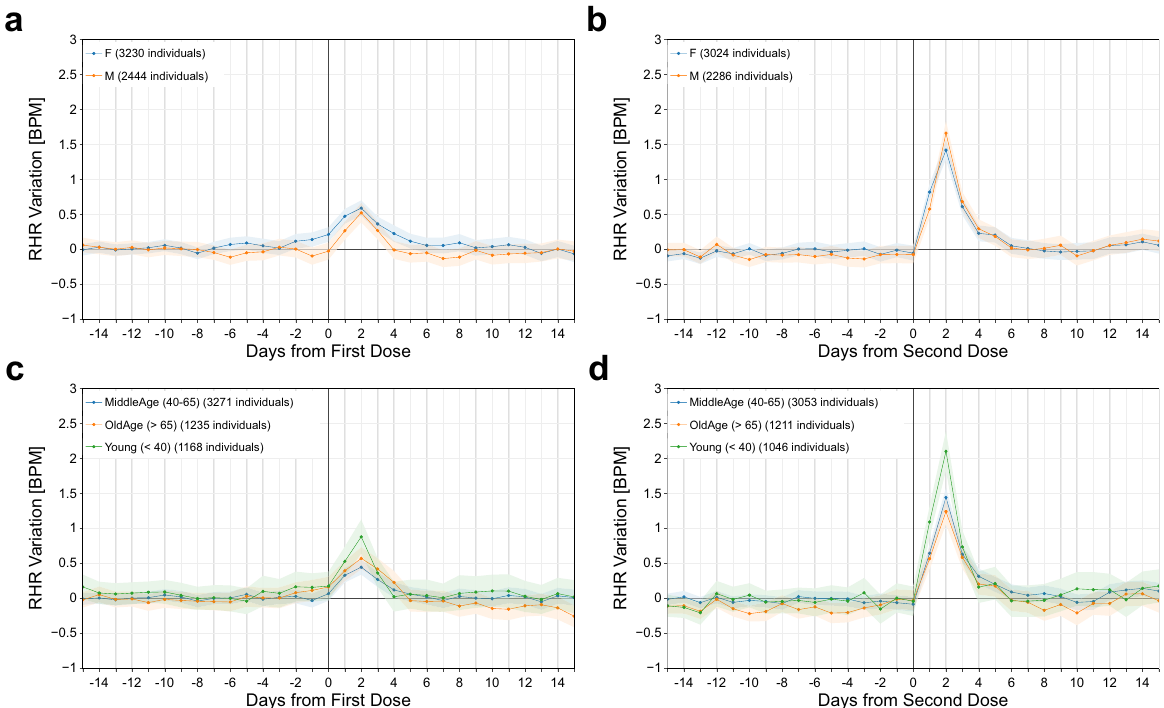
Fig. 2 Resting heart rate changes by sex and age. Mean and 95% con fi dence interval of the absolute individual changes in resting heart rate (in BPM) with respect to the individual baseline around the date of vaccination (day 0), for the fi rst dose of the vaccine ( a ), ( c ), and for the second dose ( b ), ( d ), for all individuals grouped by gender ( a ), ( b ) and age ( c ), ( d ).